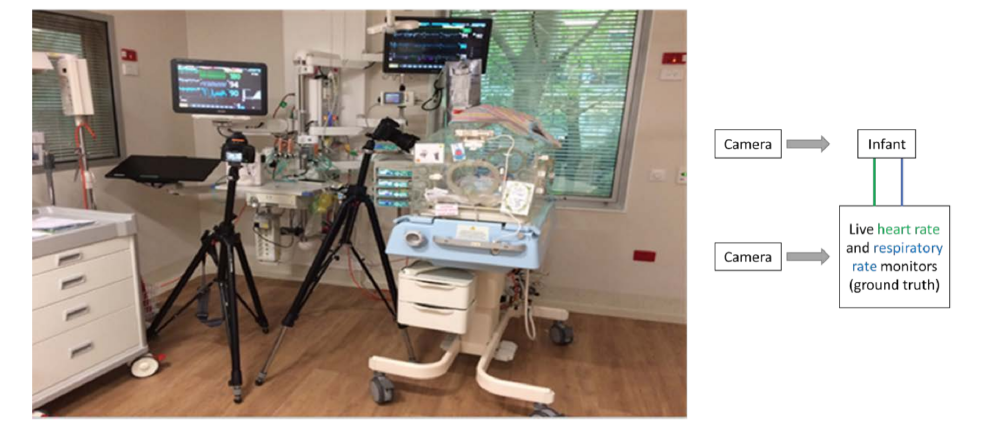
Figure 1. The experimental setup where the data recording was performed. A schematic of the setup is shown to the right of the image. A camera was mounted on a tripod closer to the infant to record the infant body’s heart rate and respiratory rate. Another camera was mounted on a tripod to capture vital signs’ ground truth (shown on the monitor). A schematic diagram on the left of the figure shows an overview of the setting.